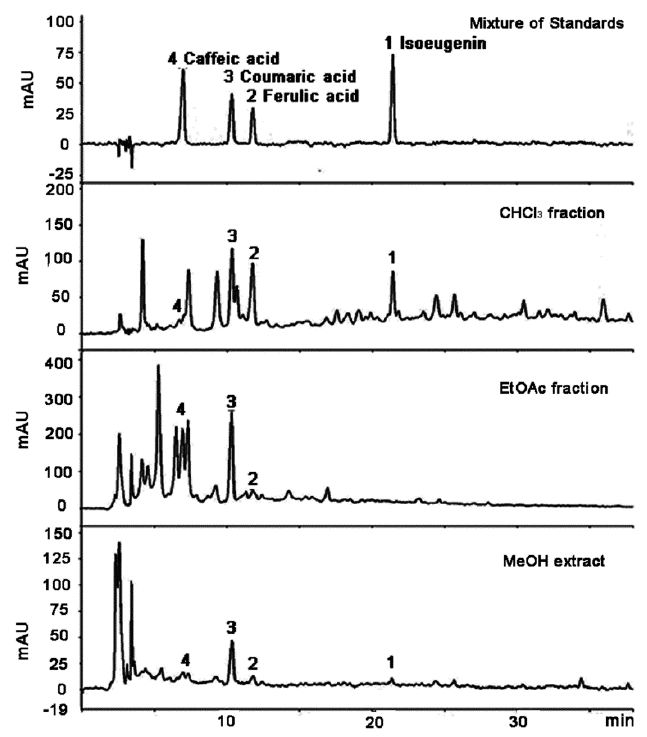
Figure 2. HPLC chromatograms of the MeOH extract of I. cylindrica and its fractions. Table 1. Linearity of standard curves and detection/quantification limits for the standard compounds.